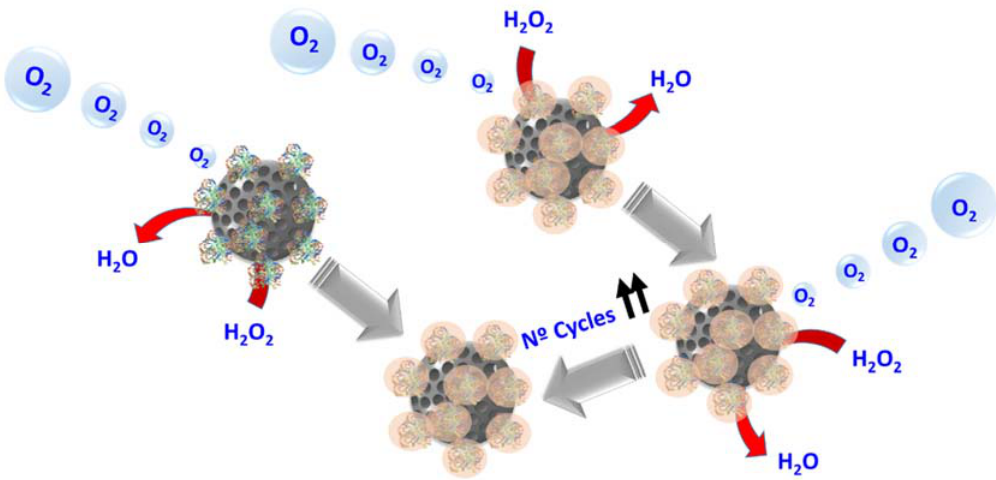
Figure 4. Scheme of nanomotors of mesoporous silica nanoparticles with catalase